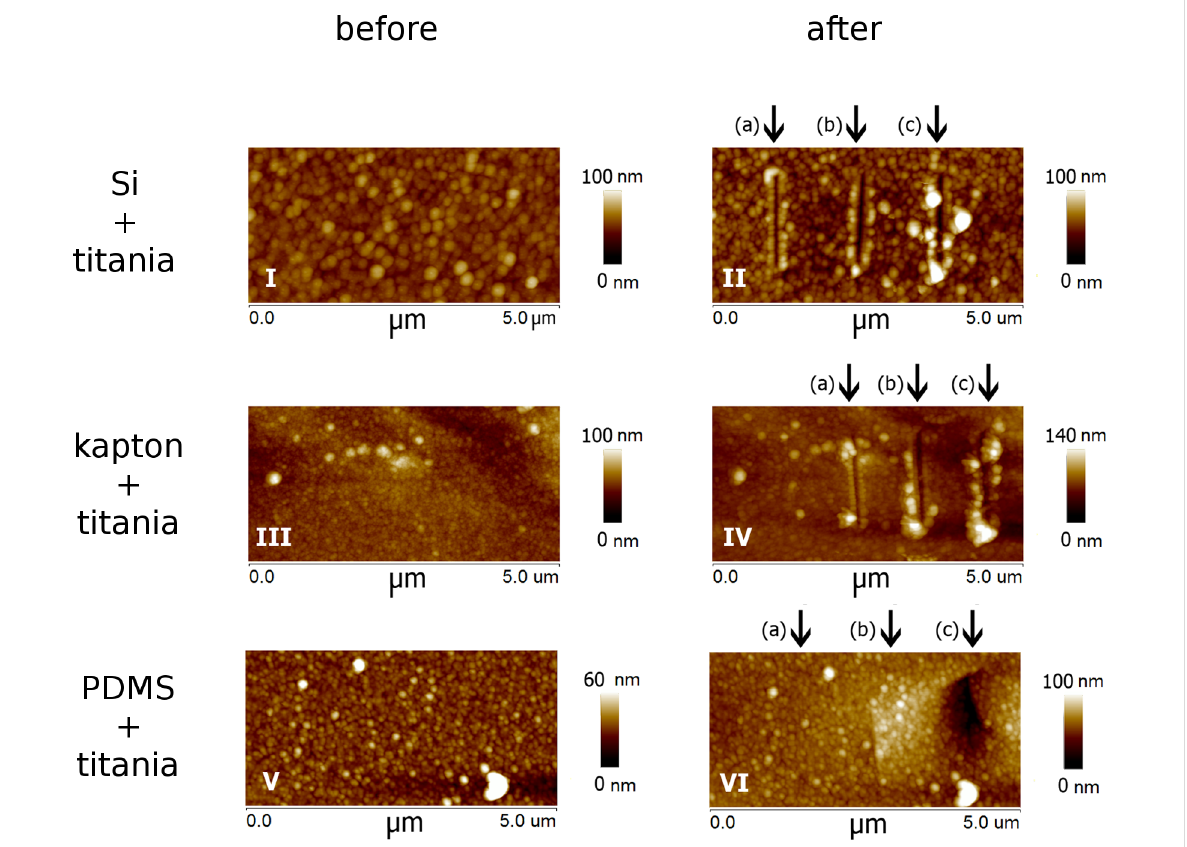
Figure 3: AFM images of titania on Si (I, II), kapton (III, IV) and PDMS (V, VI) before and after scratching loads for the 3 scratch lines were a) 15 µN, b) 20 µN, c) 25 µN.